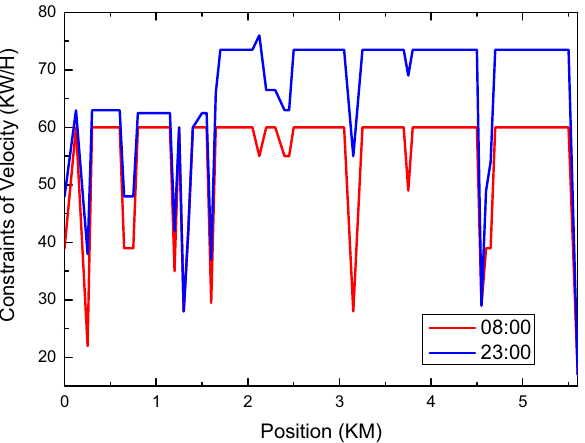
Figure 10. This figure reflects the change law of speed between 8 a.m. and 11 p.m. it can be seen from this figure that the speed limit at 11 p.m. is significantly greater than that at 8 a.m.